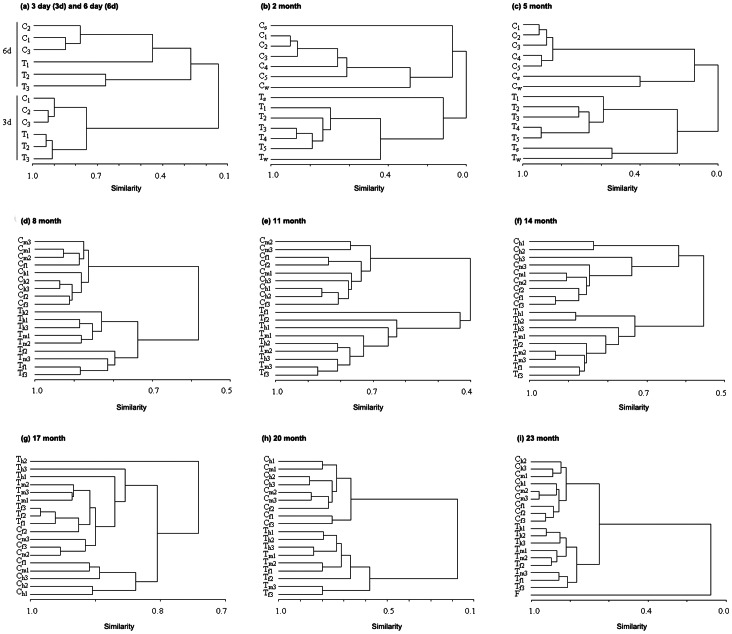
UPGMA clustering over Sørensen similarity of gut microbiota composition between transgenic fish and wild-type controls across different developmental stages.The similarity matrix was calculated using the binary data, and clustering was performed using the unweighted pair-group method with arithmetic average (UPGMA). Ti and Ci indicate the ith replication of transgenic fish and wild-type control, respectively; Tfi, Tmi, and Thi represent the ith foregut, midgut, and hindgut samples from transgenic fish, respectively, and Cfi, Cmi, and Chi from the corresponding part of controls; Ts and Tw represent the sediment and water samples collected from the pond where transgenic fish were reared, and Cs and Cw represent controls; F indicates food sample.